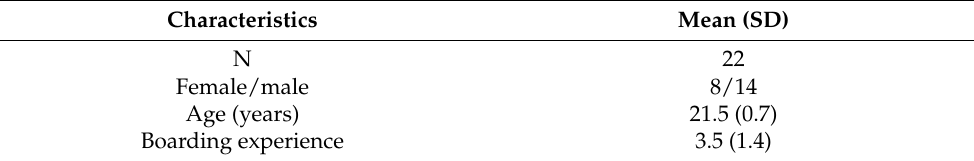
Table 1. Participant characteristics.